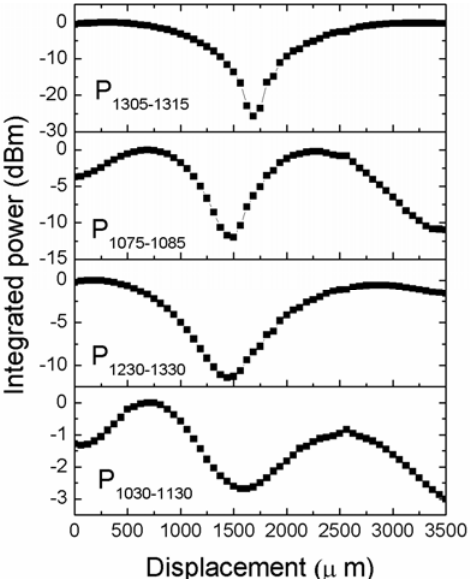
Figure 6. Integrated spectral power as a function of displacement at several spectral